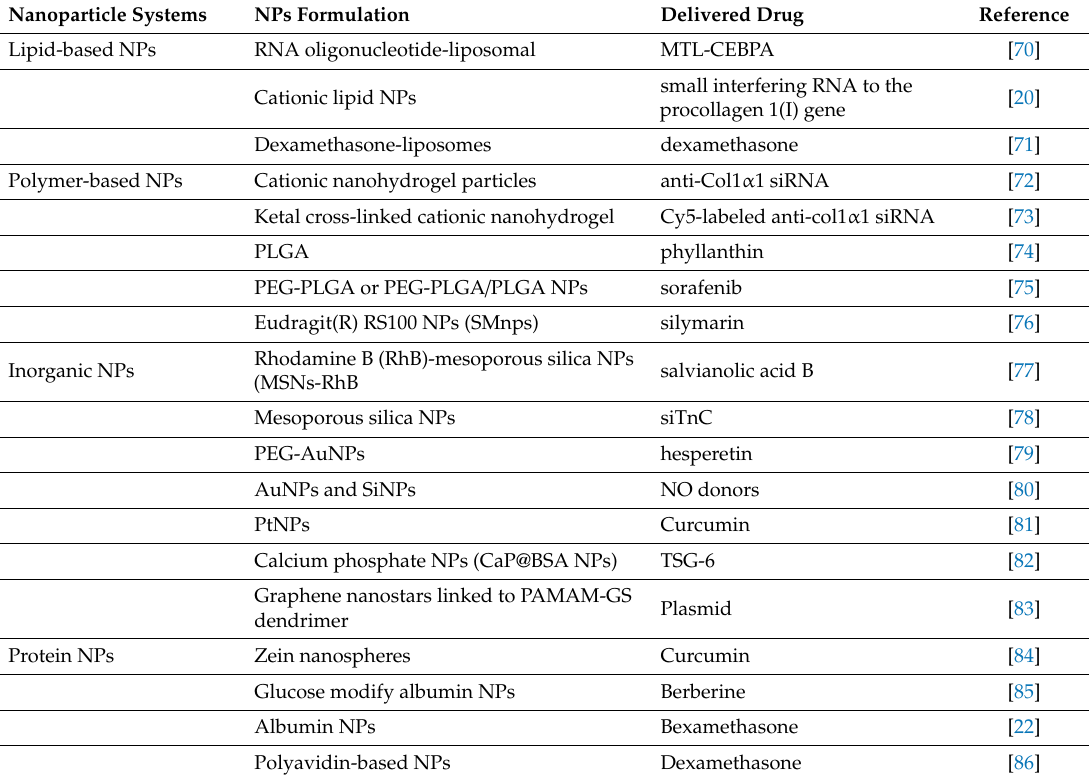
Table 1. NPs as drug carriers without targeting ligands in liver fibrosis treatment.